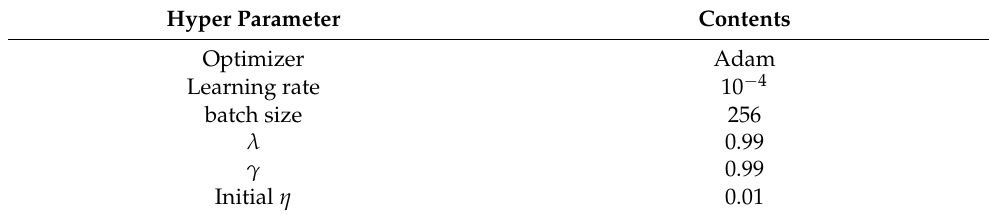
Table 1. Hyper parameters for MO-V-MPO.